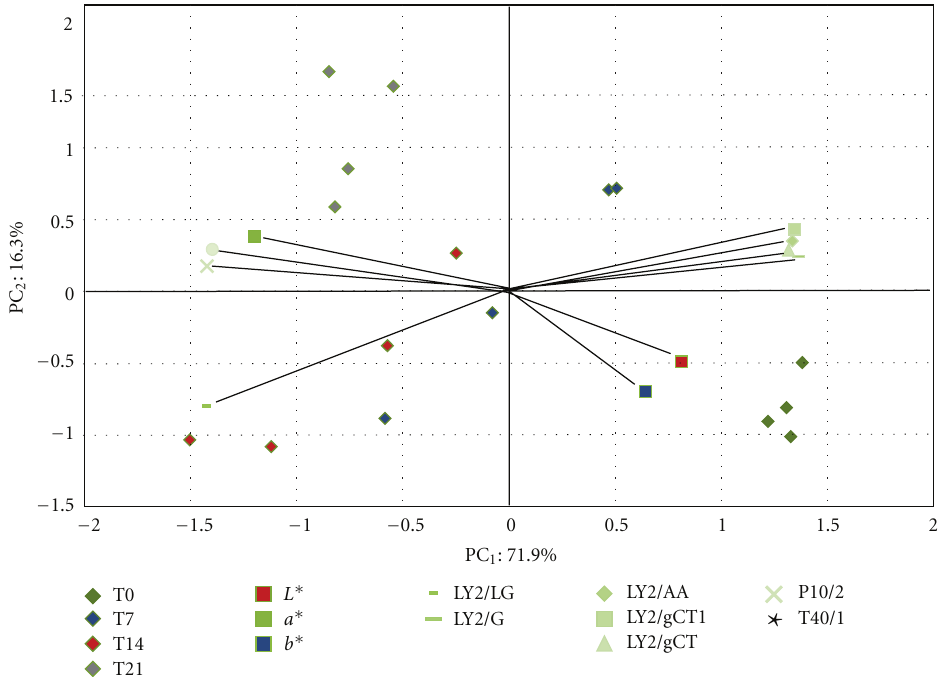
Figure 4: Principal component analysis (PCA) of electronic data (LY2/G( − ), LY2/LG(-), LY2/AA( (cid:4) ), LY2/gCTl( (cid:2) ), LY2/gCT( (cid:3) ), P10/2( × ), and T40/1( (cid:2) )) for organoleptic mature overexpressed tomato during 0 (T0, green rhombus), 7 (T7, blue rhombus), 14 (T14, red rhombus) and 21 (T21, grey rhombus) days of storage and colour parameters ( a ∗ (green square), b ∗ (blue square) and L ∗ (red